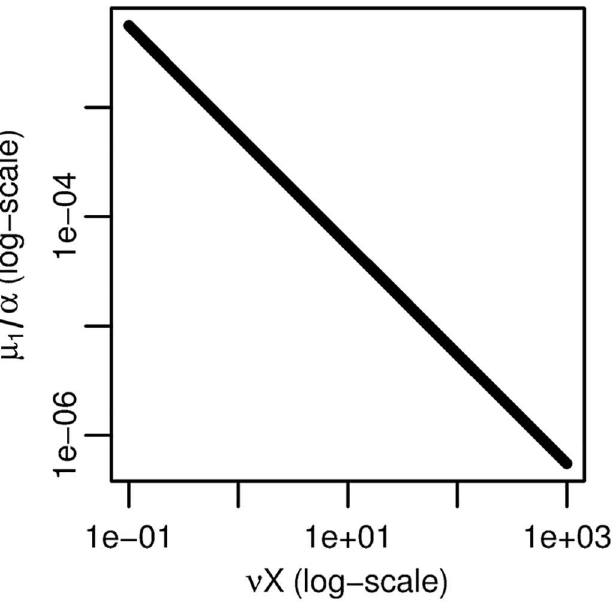
Fig 6. Three-stage model parameter dependency. Fitted value of μ 1 / α as ν X is variedfor the three-stage clonalexpansionmodel. The linear relationship on a log–logscale indicatesan identifiable product.